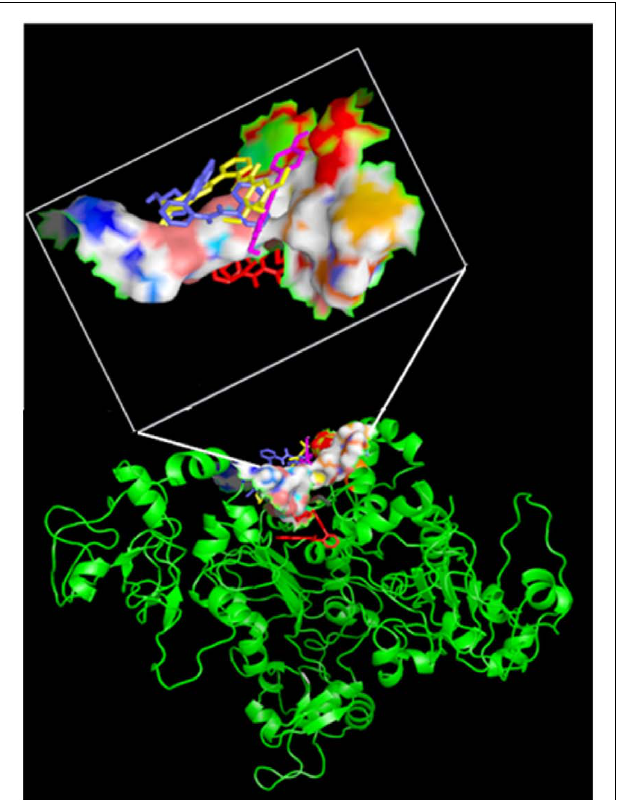
FIGURE 5 | Side view of four activators docked on the active site. All the four activators are shown in “stick” confirmation with different colors: SRT1460 in yellow, SRT2183 in blue, resveratrol magenta and SRT1720 in red).The active site residues are shown in “surface” confirmation whereas Sirt-1 by cartoon.The active site region with the docked activators is highlighted in a white